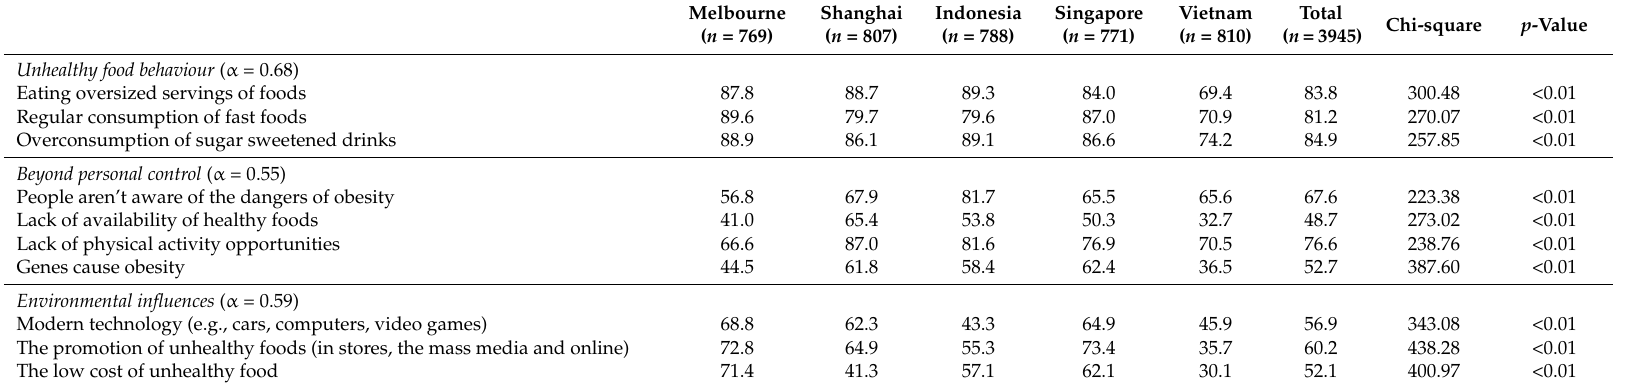
Note: Not all items loaded on the confirmatory factors, see Supplementary Materials.